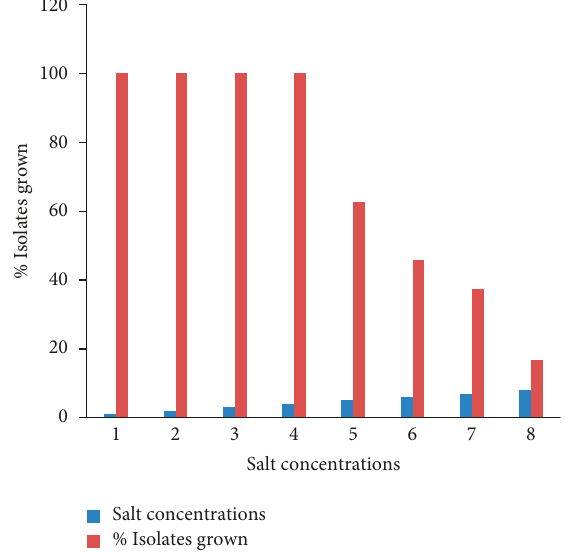
Figure 3: The growth of the rhizobial isolates at different salt